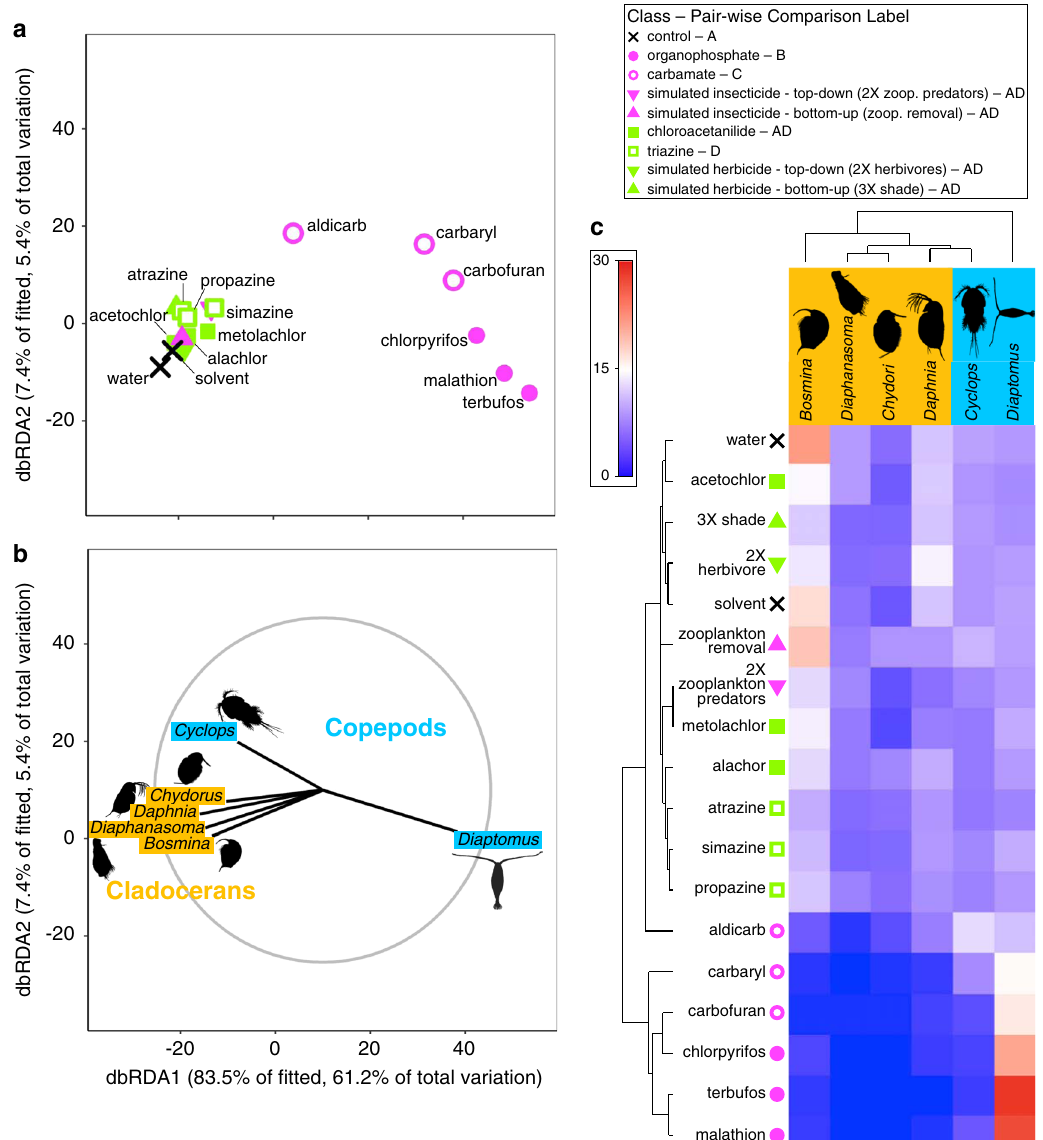
Fig. 2 Zooplankton communities respond consistently to pesticides within type, class, and individual pesticide. a Distance-based redundancy analysis (dbRDA) plot of multivariate zooplankton densities by genera showing differences among treatments grouped by type, class, and individual pesticide. Individual points correspond to the 18 treatments in the experiment. For pair-wise comparisons, treatments sharing letters are not different from each other. b Vector overlay of zooplankton responses for the corresponding dbRDA plot. The gray circle corresponds to vector lengths that would have a correlation coef fi cient of one with each axis. c Cluster diagram of experimental treatments and zooplankton densities showing differences among type, class, and individual pesticide. The scale bar shows the magnitude of the effect of a treatment on an individual response. The values of the colors correspond to the averaged and normalized treatment responses (see “ Methods ” separately on the single-trophic-level zooplankton community (six zooplankton genera) and on the tri-trophic community (insect and salamander predators, snail and anuran herbivores, and periphyton and phytoplankton primary producers). Similar to ecosystem function, pesticide type explained the majority of the variance (44.2%) in the zooplankton community, followed by pesticide class (18.8%) (Supplementary Table 1). Distance-based redundancy analysis (dbRDA) showed that: (1) herbicide-treated and insecticide-treated mesocosms had distinct zooplankton communities, (2) within their respective pesticide types, orga- nophosphate insecticides, chloroacetanilide herbicides, and tria- zine herbicides caused further distinction in zooplankton communities, and (3) there was relatively high multivariate